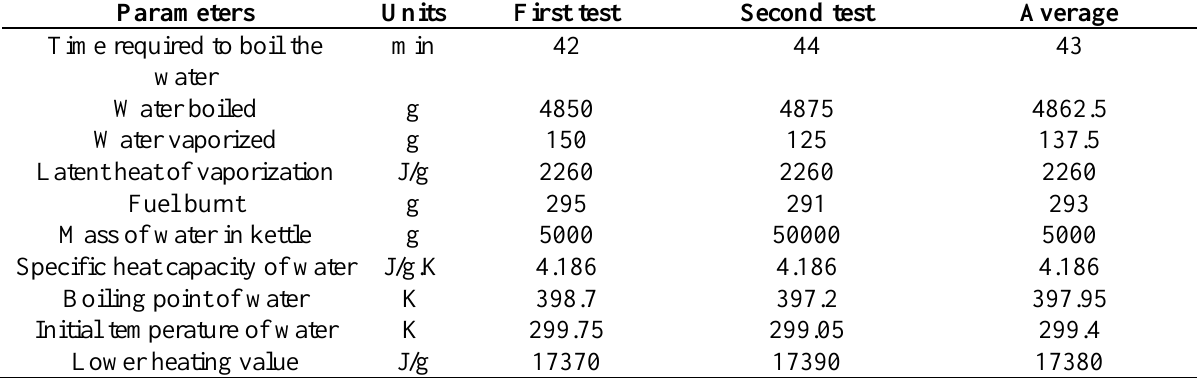
Table 3. Data obtained for water boiling test of the improved smokeless